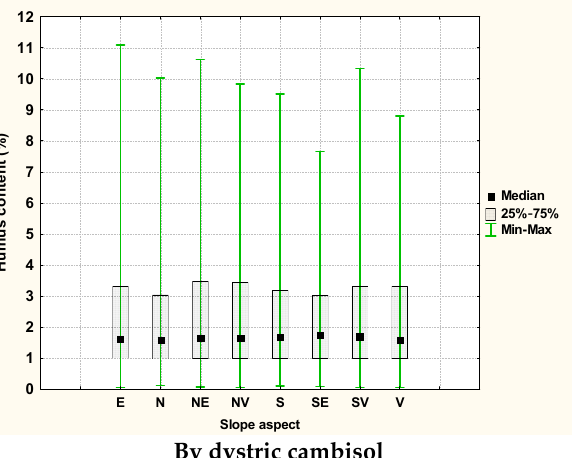
Figure 3. The variation of soil organic matter content in Bv horizon of dystric cambisol.